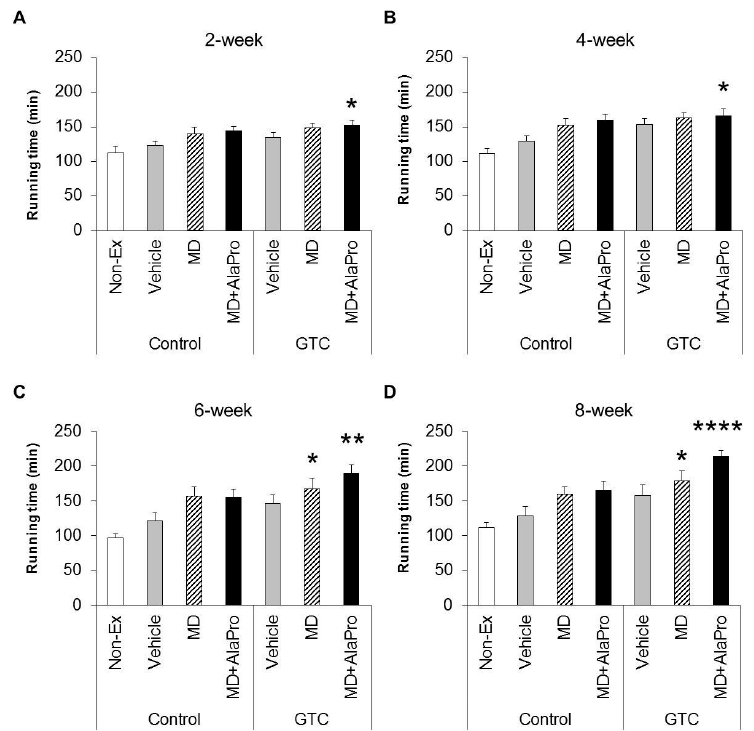
Figure 1. Running time to exhaustion as measured to evaluate endurance capacity at the ( A ) 2; ( B ) 4; ( C ) 6, and ( D ) 8-week test period. Values are means ± SE ( n = 8, Non-Ex and GTC + MD at 8-week: n = 7). * P < 0.05, ** P < 0.01, **** P < 0.0001 vs. Control-Vehicle group (Dunnett’s test).